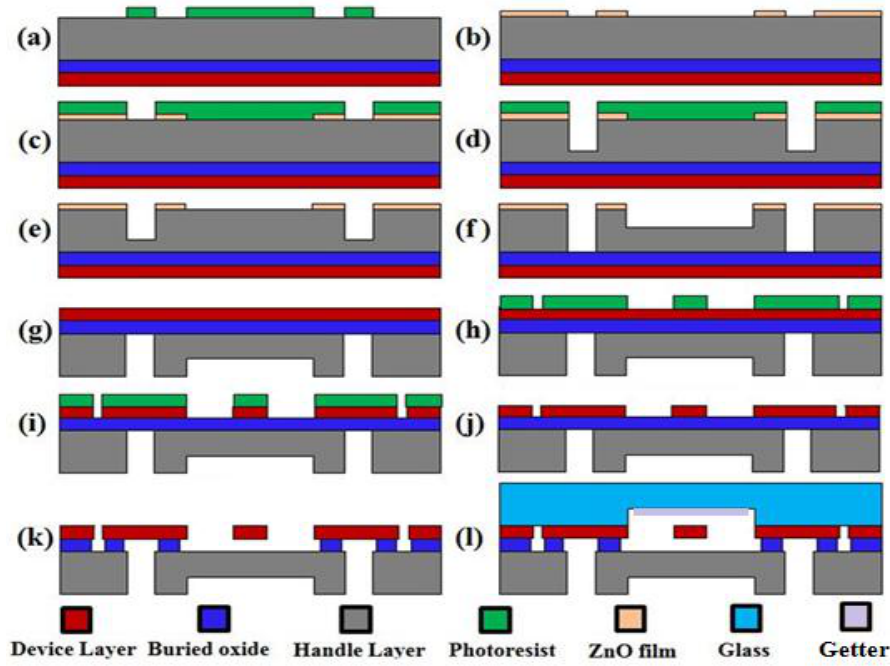
Figure 2. Device fabrication flow charts: ( a , b ) Patterning the ZnO film based on e-beam evaporation and lift-off process; ( c , d ) Patterning photoresist on the ZnO film as a mask to form via holes; ( e , f ) Forming via holes and diaphragm using the patterned ZnO film as hard mask; ( g – j ) Fabricating resonators on the device layer based on photolithography and dry etching; ( k ) Removing the oxide layer in vapor HF to release resonators; ( l ) Vacuum packaging of the fabricated silicon wafer and the glass cap wafer using anodic